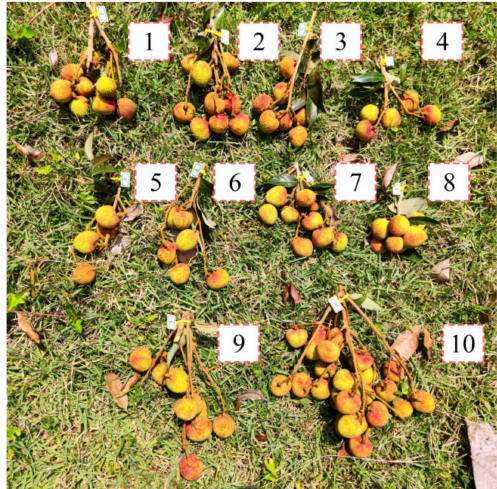
Figure 12. Experimental preparation.